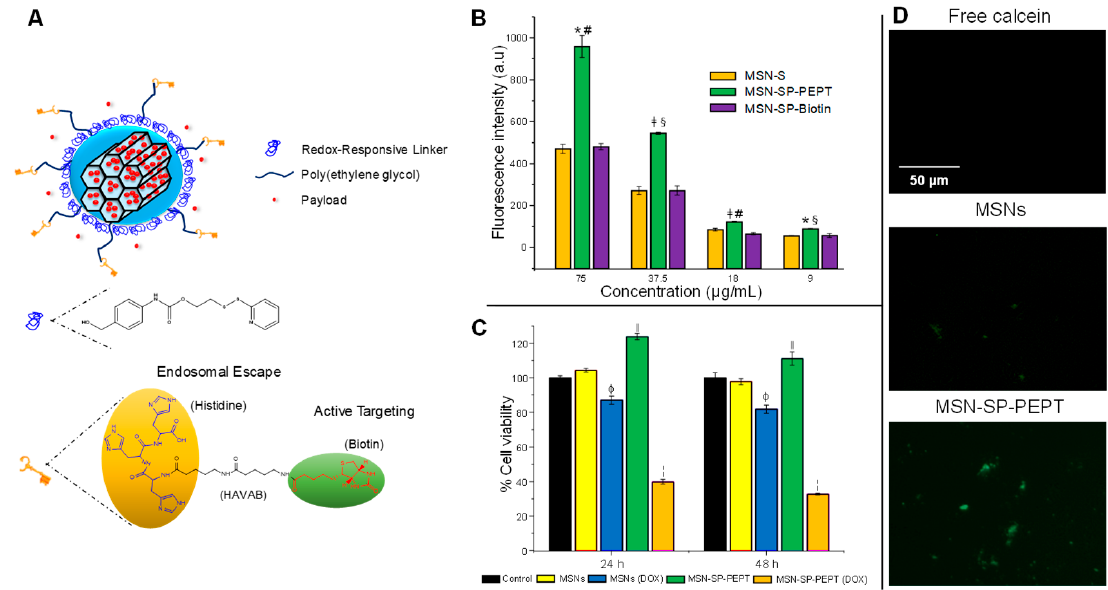
Figure 5. ( A ) Schematic representation of the redox-responsive targeted MSNs. ( B ) Flow cytometry on HeLa cells demonstrated that the highest internalization was obtained for group containing both the biotin and the histidine motifs. ( C ) The redox-responsive, targeted MSNs exerted significant cytotoxicity on A549 cells when loaded with doxorubicin at short time. ( D ) The calcein assay demonstrated that only the group bearing the peptidic molecule was able to escape the endosomes. Adapted with permission from [35]. Copyright ACS, 2021.